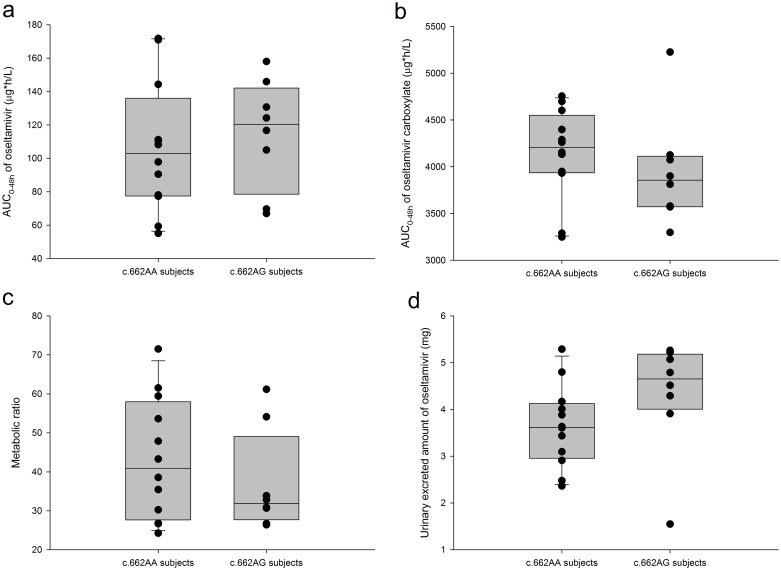
Comparison of PK parameters between genotype groups.The metabolic ratio was calculated as the AUC0-48h, oseltamivir carboxylate / AUC0-48h, oseltamivir. The solid lines across the box, the top edge, and the bottom edge represent the median, the 75th percentile, and the 25th percentile, respectively. The horizontal lines connected with the whiskers extending from the box denote the 90th and 10th percentiles, respectively. The dots outside of the whiskers represent outliers.